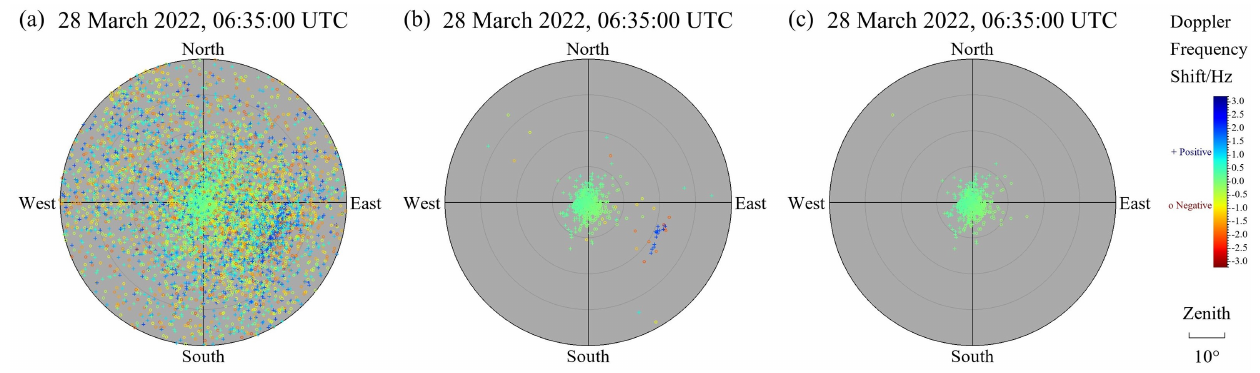
Figure 5. Case of Doppler filtering. ( a ) Distribution of reflection points after ionospheric detec- tion region restriction. ( b ) Distribution of reflection points filtered by the amplitude threshold in Doppler filtering. ( c ) Distribution of reflection points filtered by Doppler frequency shift threshold in Doppler